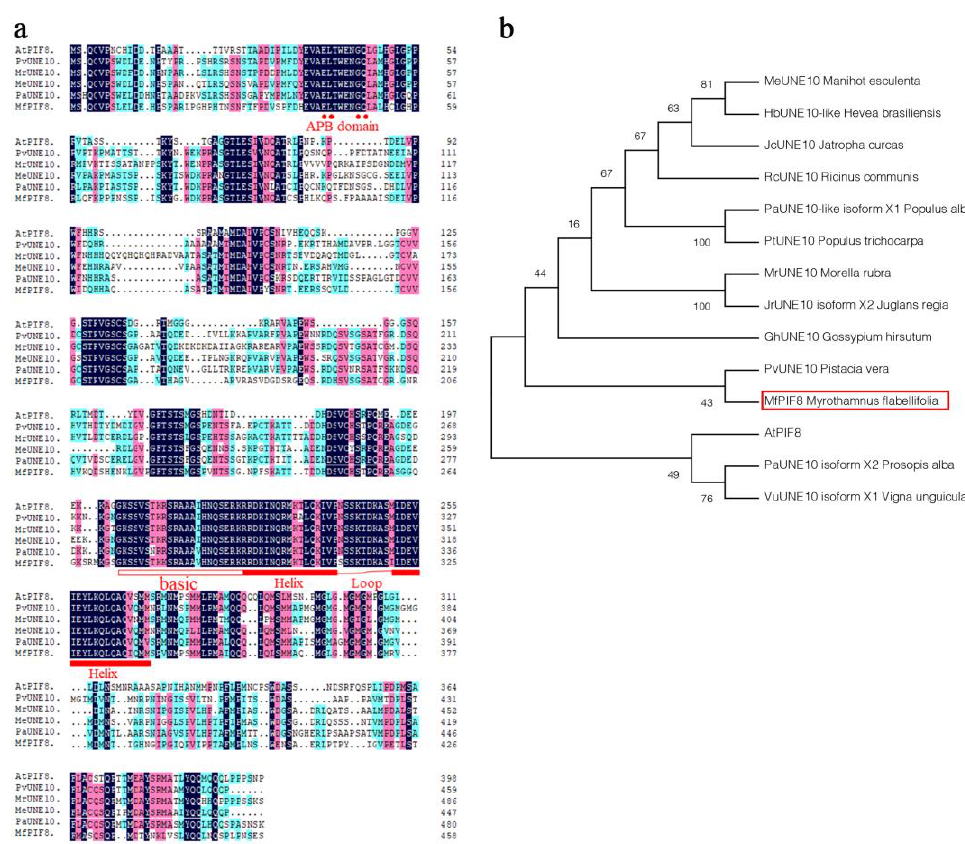
Figure 1. Multiple sequence alignment ( a ) and phylogenetic analysis ( b ) of MfPIF8 and several highly homologous bHLH proteins. ( a ) Identical and similar amino acids were highlighted. Conserved amino acid residues marked by red dots are active phytochrome B-binding (APB). The basic region was marked by the blank box, and the curve-linked red boxes indicate the conserved HLH domain. ( b ) Phylogenetic tree constructed using the neighbor-joining method. MfPIF8 is indicated by a hollow red box. The GenBank accession numbers and corresponding species for the sequences analyzed are listed in Table S1.